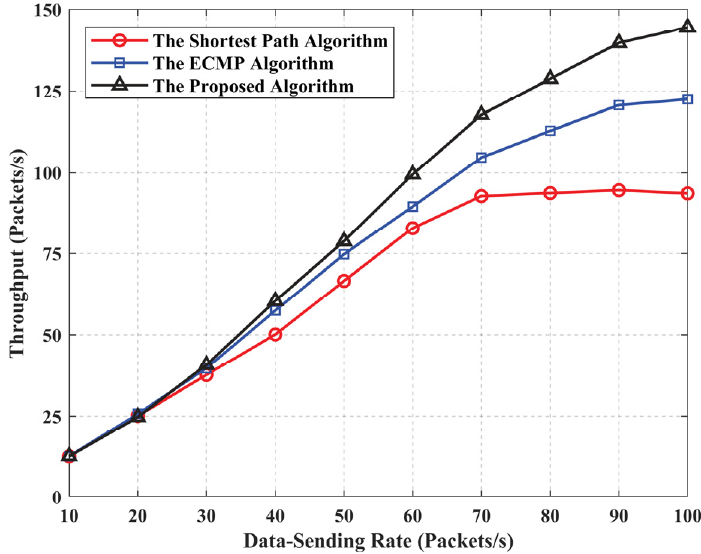
Figure 9. Throughput at different data sending rates. To study the effect of topology size on algorithm performance, the data sending rate is fixed at 70 packets/s and the number of topological nodes is increased from 4 to 28. The experimental results are shown in Figures 10–12. Figure 10 explains the average end-to- end delay with a different number of topological nodes. The figure illustrates that as the number of topological nodes increases the average end-to-end delay of the shortest path algorithm first increases and then levels off, while the ECMP algorithm and the proposed algorithm first decrease and then level off. Figure 11 shows the packet loss rate with a different number of topological nodes. In this figure, the variation of packet loss rate with topological nodes follows the same trend as the average end-to-end delay in Figure 10. Figure 12 indicates that the throughput of the shortest path algorithm decreases first and then levels off as the number of topological nodes increases. The results show that the shortest path routing algorithm gives the worst network performance due to selecting only one shortest path for data transmission, which is prone to network congestion. When the number of topological nodes is small, the available shortest paths are also very few, so the proposed algorithm cannot exert its ability to dynamically select the optimal path and the network performance is poor. However, the ECMP algorithm can spread the traffic to different paths for transmission, with better network performance, which is more suitable for simple topologies with a small number of nodes. When the number of topological nodes is bigger, the network performance of the proposed algorithm is better and less volatile compared with the ECMP algorithm. The proposed algorithm analyses multi-attribute parameters such as traffic, packet loss rate, and transmission delay, which can dynamically select the optimal path according to the network performance, effectively alleviate network congestion and improve network